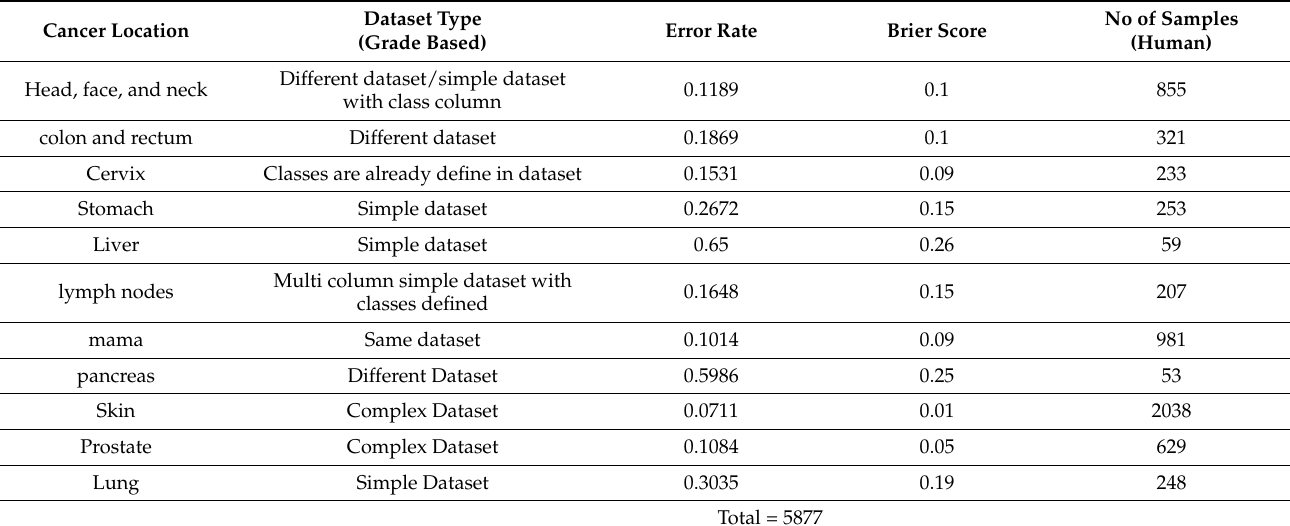
Table 1. Prediction error rate: prediction error rate and average Brier Score value for each type of cancer, considering a total of 1000 trees